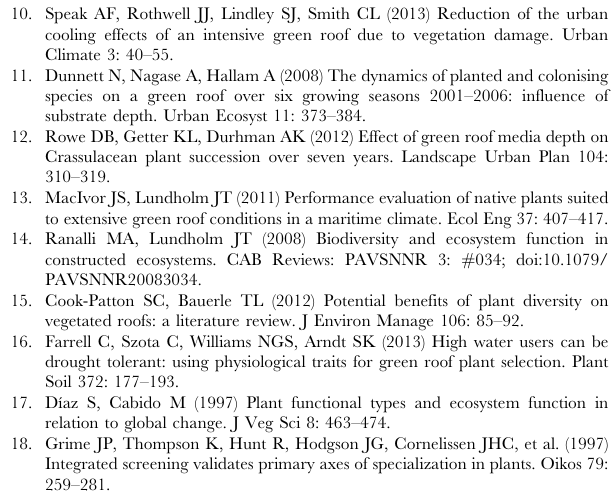
Table S1 Plant trait values for each species. Table S2 Canopy density for each species in each treatment over four years. Table S3 Details of principal component analysis of plant